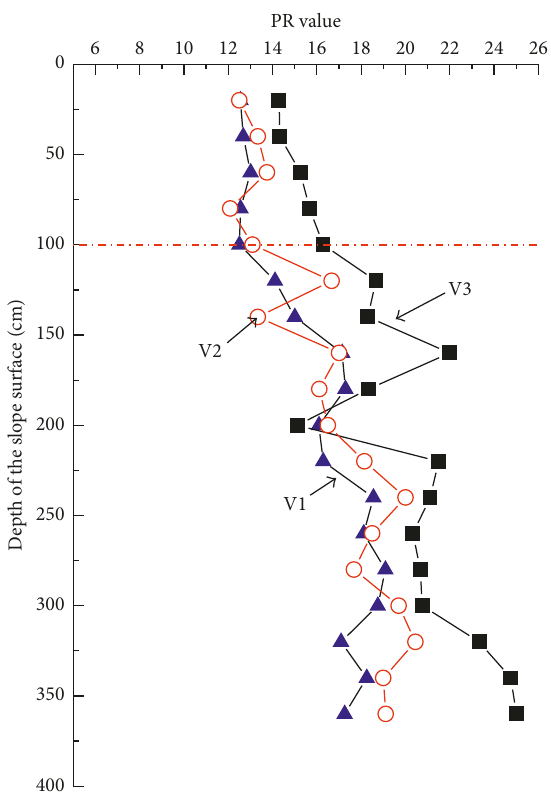
Figure 5: PR values for different